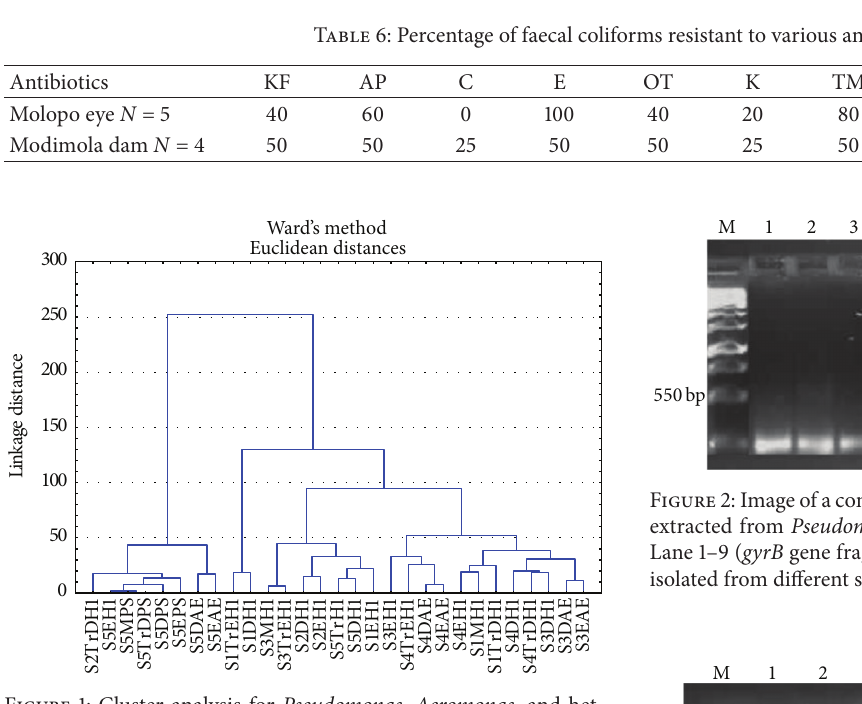
Figure 1: Cluster analysis for Pseudomonas , Aeromonas, and het- erotrophic bacteria isolated from different sites within the various clusters (PS: Pseudomonas ; AE: Aeromonas , H: heterotrophic bacte- ria).